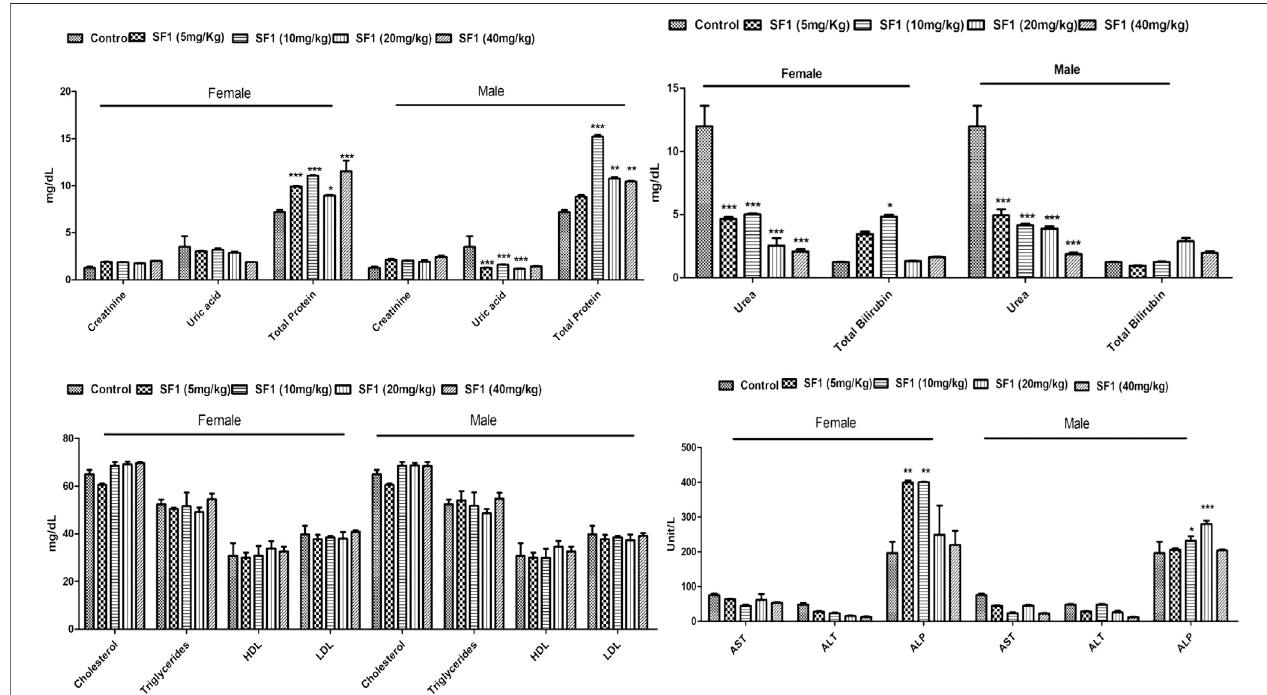
FIGURE 6 | Estimation of biochemical parameters after 28 days of treatment with different dose levels of SF1 in the subacute study. Data represented as mean ± SEM ( n (cid:1) 10). * p < 0.05, ** p < 0.01 and *** p < 0.001 was in comparison to the control.